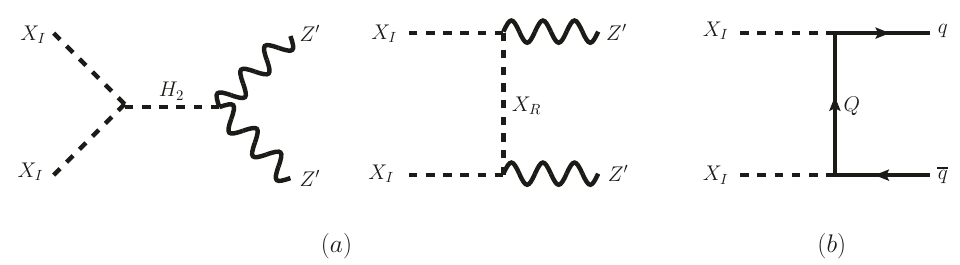
Figure 9 . Representative diagrams for the two annihilation channels: (a) X I X I